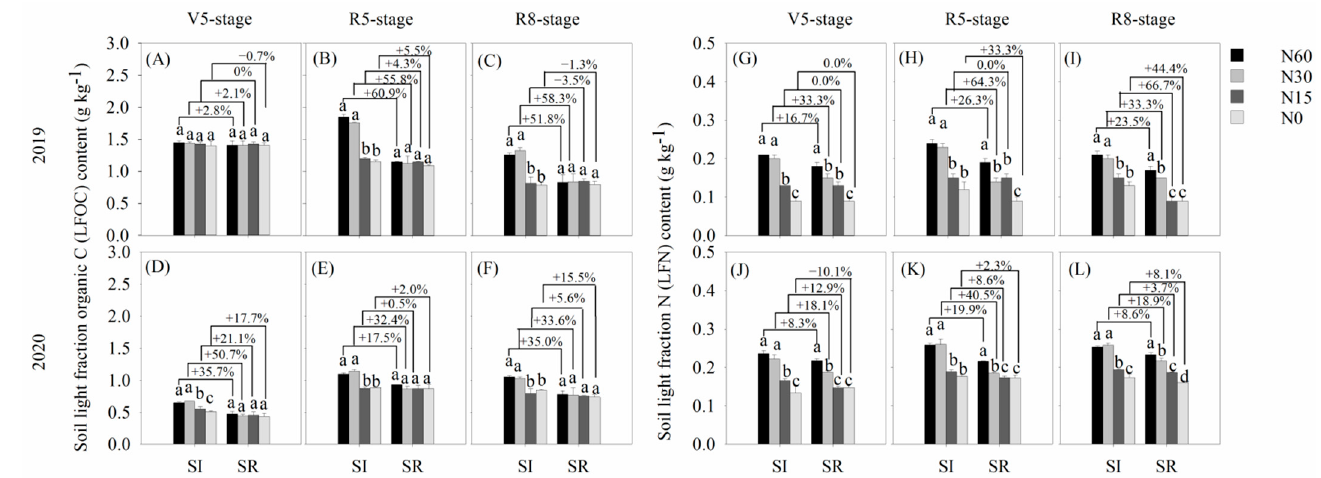
Figure 4. Soil light fraction organic carbon and nitrogen content at the different soybean growth stages. ( A ) LFOC content at the V5 stage of soybean in 2019, ( B ) LFOC content at the R5 stage of soybean in 2019, ( C ) LFOC content at the R8 stage of soybean in 2019, ( D ) LFOC content at the V5 stage of soybean in 2020, ( E ) LFOC content at the R5 stage of soybean in 2020, ( F ) LFOC content at the R8 stage of soybean in 2020, ( G ) LFN content at the V5 stage of soybean in 2019, ( H ) LFN content at the R5 stage of soybean in 2019, ( I ) LFN content at the R8 stage of soybean in 2019, ( J ) LFN content at the V5 stage of soybean in 2020, ( K ) LFN content at the R5 stage of soybean in 2020, ( L ) LFN content at the R8 stage of soybean in 2020. In each panel, different lower-case letters “a – d” indicate significant differences under different N application rates within the same straw treatment (LSD, p < 0.05). Same lower-case letters indicate no significant differences under different N application rates within the same straw treatment (LSD, p < 0.05). Data were shown as mean ± S.D. ( n = 3). The values indicate the change in SI relative to SR, and “+” and “ − “ indicate increasing and decreasing, respectively. SI, straw incorporation; SR, straw removal; N60, convention N (60 kg N ha − 1 ); N30, reduced N by 50% (30 kg N ha − 1 ); N15, reduced N by 75% (15 kg N ha − 1 ); N0, zero N (0 kg N ha − 1 ); V5, the fifth trifoliolate stage of soybean; R5, the beginning seed stage of soybean; R8, the full-maturity stage of soybean.